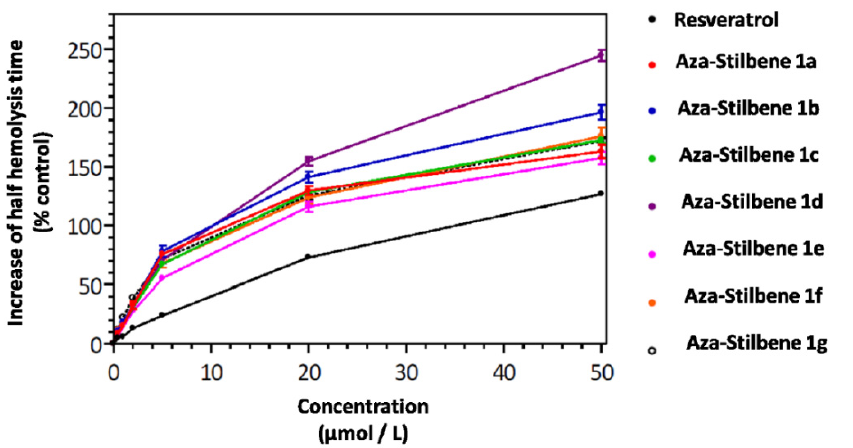
Figure 6. Quantification of the antioxidant activity of resveratrol and aza ‐ stilbenes 1a to 1g with the KRL test. KRL test.